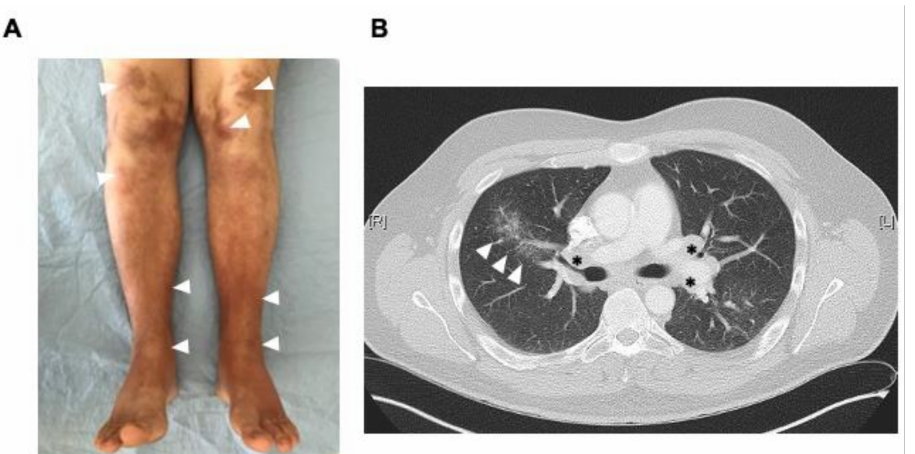
Figure 1. Clinical and radiographic findings in patient #2. ( A ). Extensive rash with erythema nodosa on both legs (arrowheads). Ankles were swollen and tender. ( B ). Chest computed tomography showing interstitial pulmonary infiltrates (arrowheads) and lymphadenopathy (asterisks).